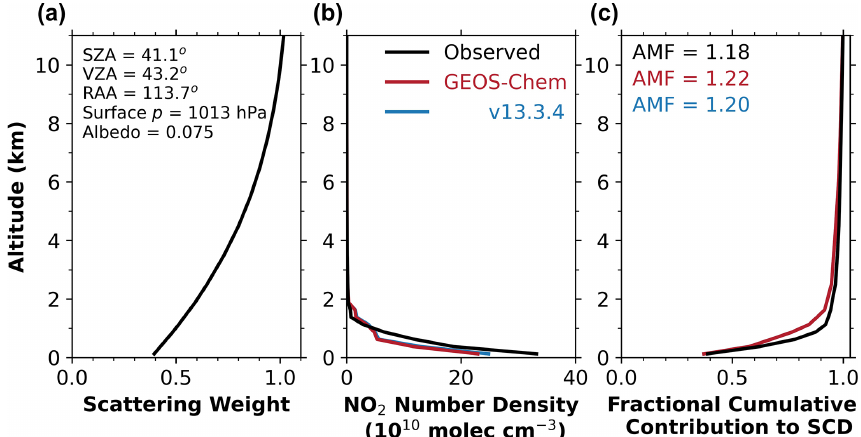
Figure 4. Sensitivity of the tropospheric NO 2 column measured from space to the vertical distribution of NO 2 . Panel (a) shows the mean clear-sky scattering weights ( w ( z ) in Eq. 3) for the ensemble of observed vertical profiles over the SMA during KORUS-AQ. The scattering weights represent the altitude-dependent sensitivity of the detected slant column to NO 2 optical depth, which is proportional to number density. Panel (b) shows observed and simulated median vertical profiles of NO 2 number density in the SMA during KORUS-AQ. Panel (c) shows the fractional cumulative contribution to the NO 2 slant tropospheric column density (SCD; (cid:127) s in Eq. 2) from NO 2 below a given altitude in the SMA. The air mass factors (AMFs; Eq. 3) given in the inset are obtained by applying the scattering weights from panel (a) to the shape factors from panel (b) and including a mean geometric AMF G of 2.70. Observed NO 2 number densities between 5 and 7km are inferred from NO observations and by applying PSS (Eq. 4). No observations were made above 7km, and GEOS-Chem values are used there